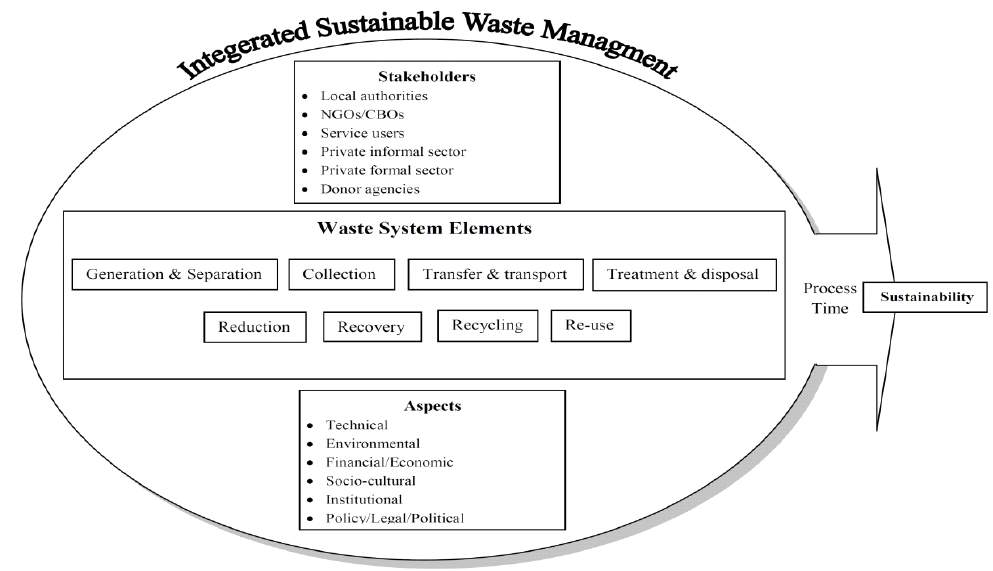
Fig. 1: The ISWM Model (Klundert and Anschutz,